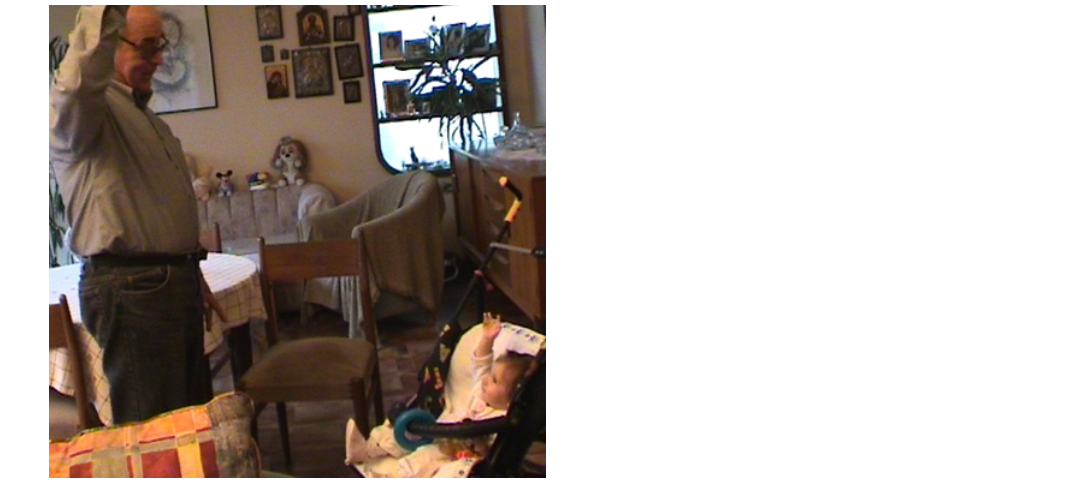
Figure 1.5. The grandfather is imitating his infant grandchild’s hand movement (see Note 1) while he is smiling and has now changed his body posture from leaning to his infant grandchild to standing upright. The infant grandchild is still keeping her right hand up and she is looking intensely at her grandfather.